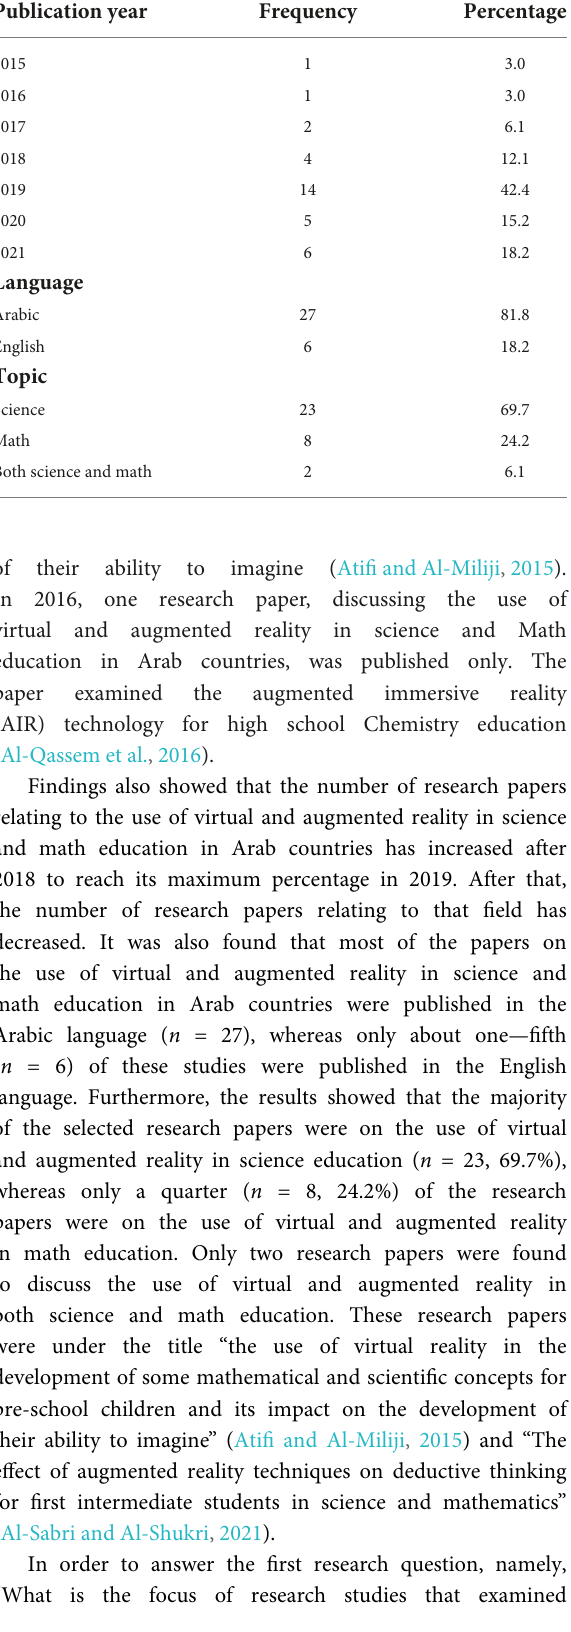
TABLE 1 Information about the selected research papers ( n = 33